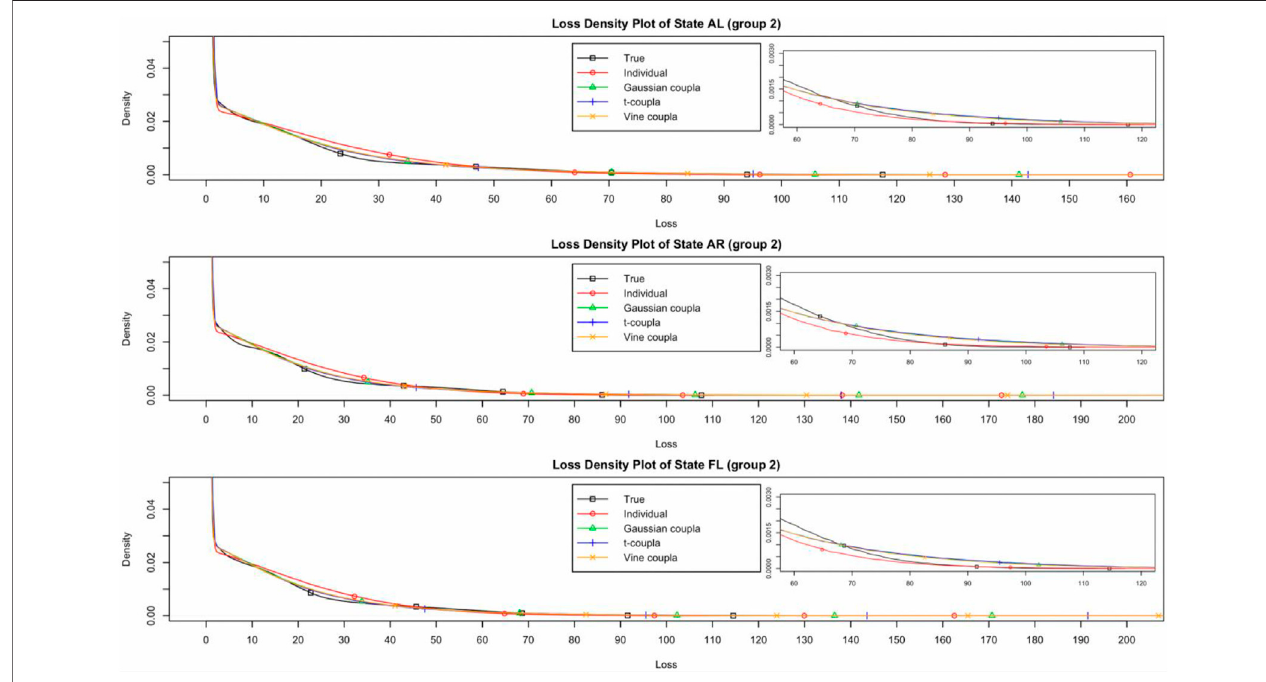
FIGURE 3 | The losses density plot for states in Group 2 (Weibull distribution with a duration of 30 years).